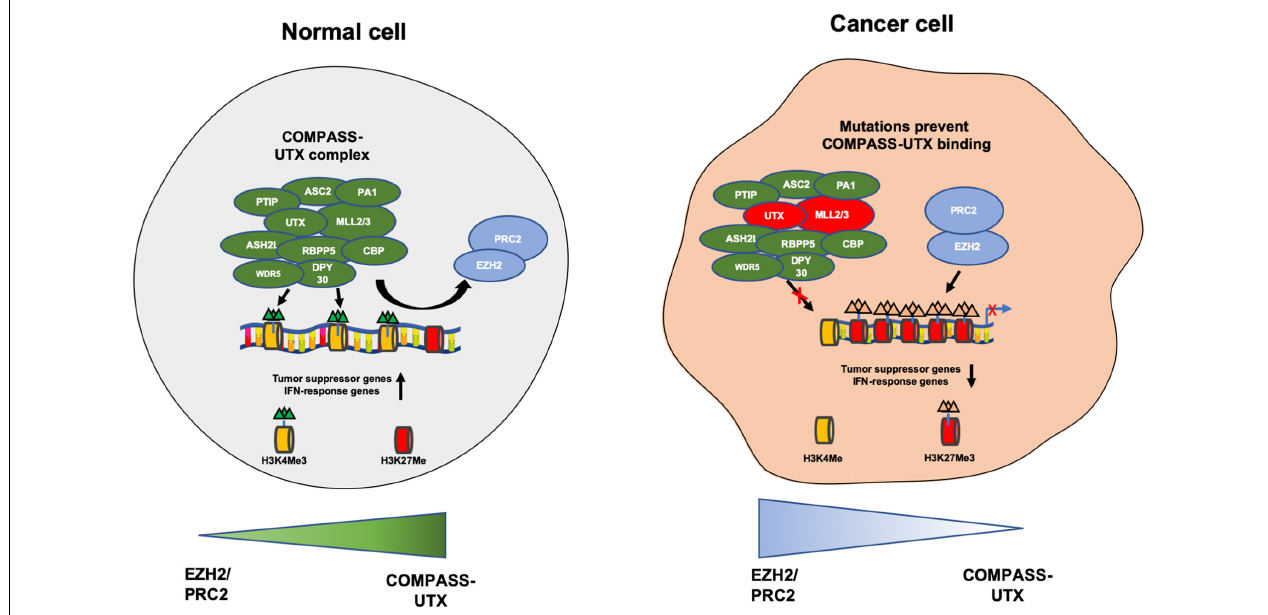
FIGURE 2 | Depicting the COMPASS complex and PCR2 complex that contribute to the open and closed chromatin states. In a normal healthy cell the COMPASS complex removes methyl groups from H3K27me3 and adds methyl groups to H3K4me and prevents PRC2 complex from adding methyl groups to H3K27me. This induces transcriptional activation of tumor suppressive and IFN-response genes. In the context of cancer UTX (KDM6A) and MLL2/3 are frequently mutated in the COMPASS complex, causing a loss of expression. This prevents UTX from binding to the compass complex and no H3K27me3 demethylation occurs, enabling the PRC2 complex to add methyl groups on H3K27me and remove methyl groups from H3K4me, inducing transcriptional repression of tumor suppressor and IFN response genes, promoting cancer cell growth.